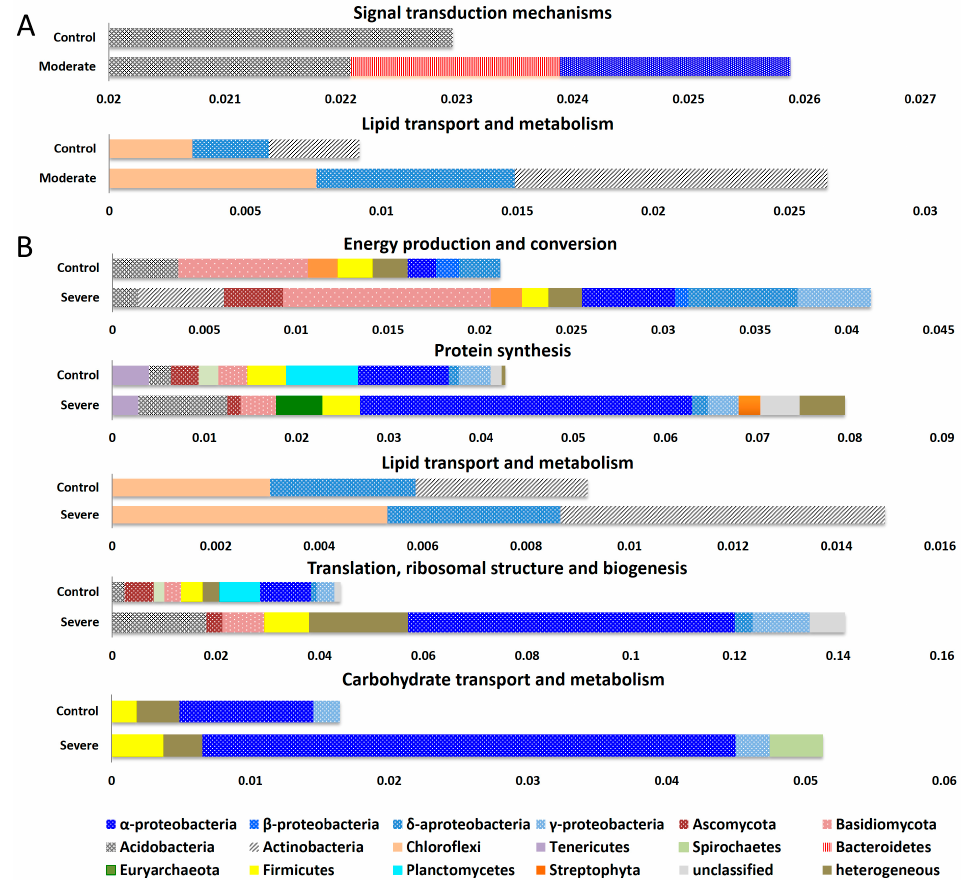
Figure 4. Microbial community functions in drying and rewetting (DRW) treatments that were different from controls ( > 100%) assigned to their taxonomic origin. ( A ) moderate DRW; ( B ) severe DRW. Microbial community functionality is based on normalized spectral abundance factors (NSAFs) of microbial proteins. Values on the x-axes are NSAF values of microbial functions assigned to their phylogentetic origin at class-level. To indicate their origin on the phylum level, shadings were included: blue dotted bars indicate Proteobacteria, red dotted bars indicate Fungi, Acidobacteria are crosshatched, Actinobacteria are striped from bottom left to top right, Bacteroidetes are vertical red lines, and heterogenous are plain.